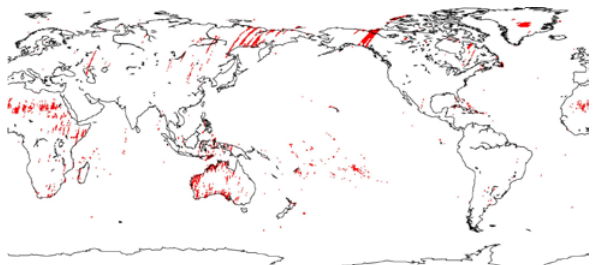
Figure 5. ASTER GDEM-3 DAR aiming at further reduction of bad